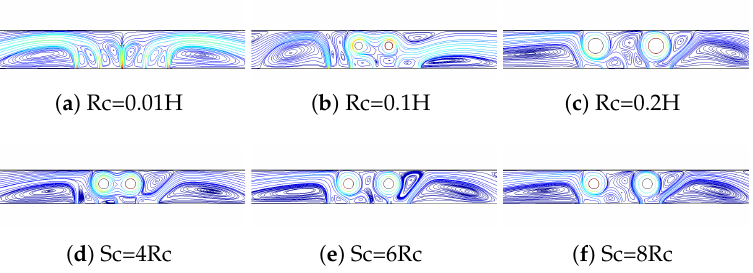
Figure 6. Impacts of RCC size (Sc = 6Rc, ( a – c )) distance between the cylinders (Rc = 0.1H, ( d – f )) on the FP distributions ( ( Rew 1 ,Rew 2 ) = ( − 20, − 20 ) , ∆ T = 10, SVF = 3%.) The average Nu rises with higher cylinder sizes. This is attributed to the favorable impacts of rotations when cylinder sizes are larger. The subcooling of the system is achieved by using cylinders which are maintained at lower cold jet temperature of Tc-dTc (Figure